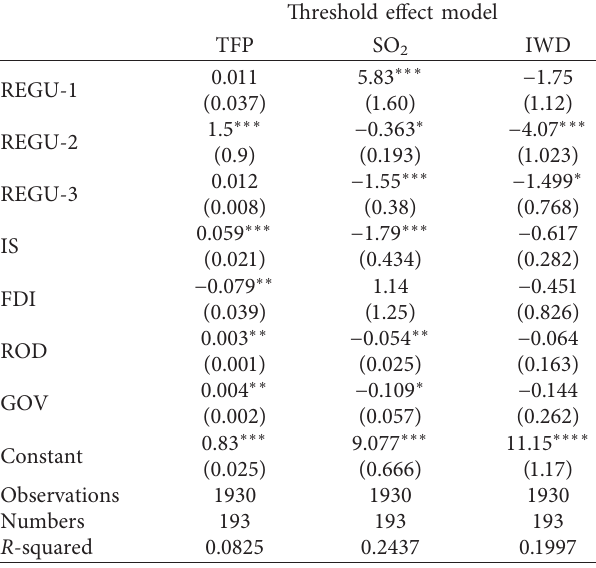
Table 7: The results of the lagging regression of the threshold